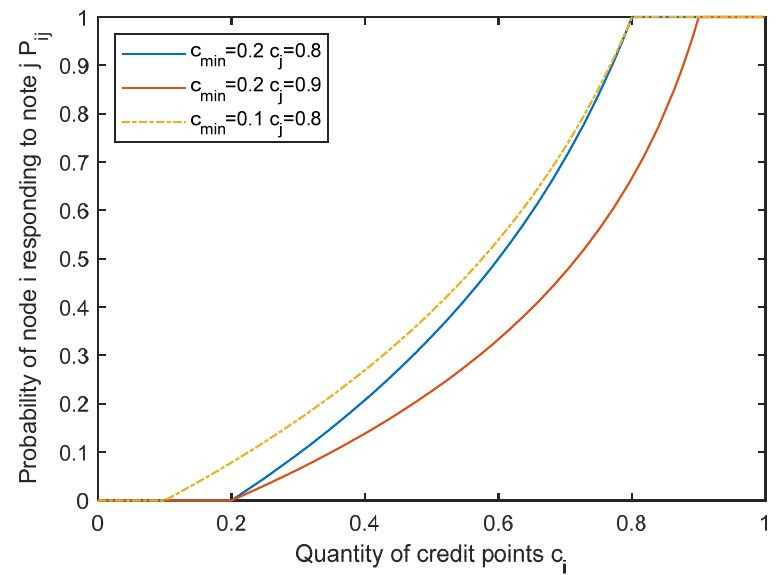
c varies. Figure 3. The probability P i